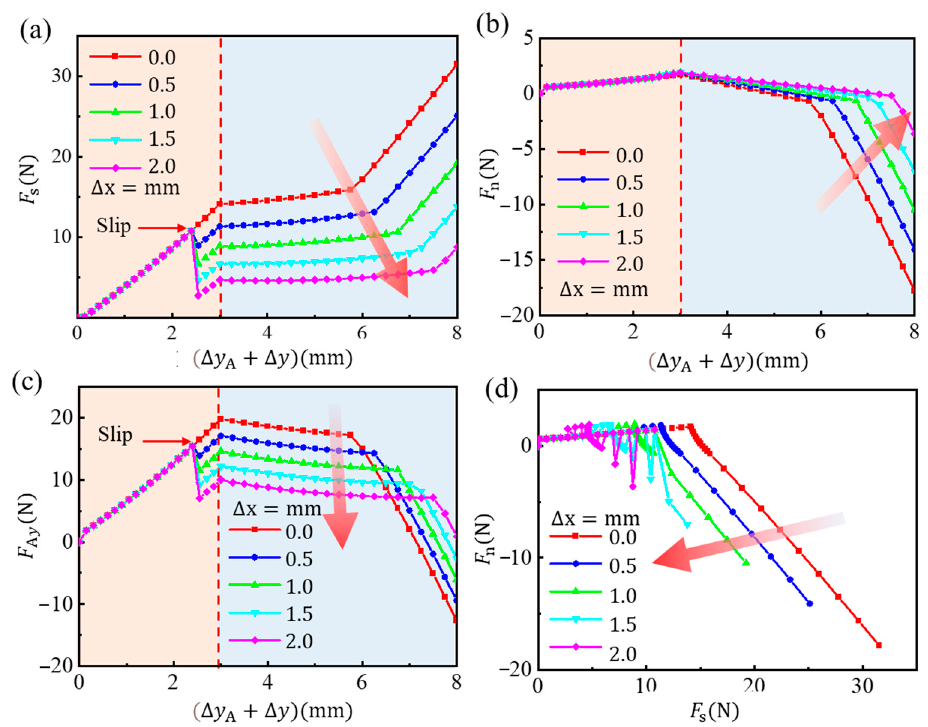
Figure 7. The forces of the single foot of the spines in the process of grasping and attaching. ( a ) Tangential force of needle tip. ( b ) Normal force of needle tip. ( c ) Normal force at hinge point A. ( d ) Stress diagram of needle tip in force space.